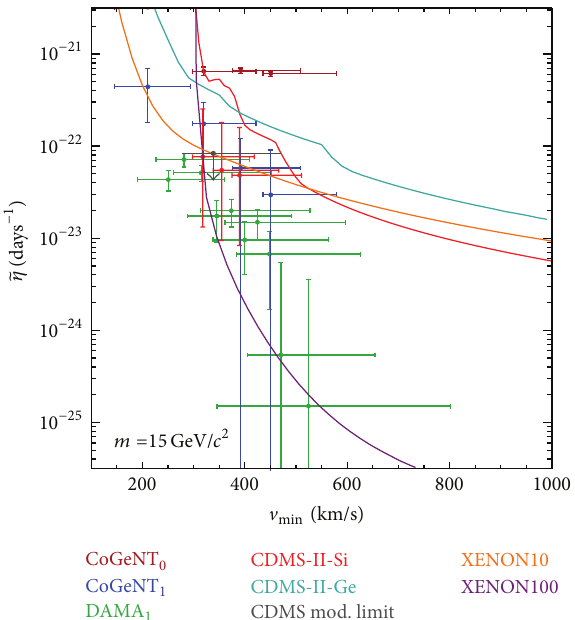
Figure 6: As in Figure 4 but for 𝑚 = 15 GeV/ 𝑐 2 .